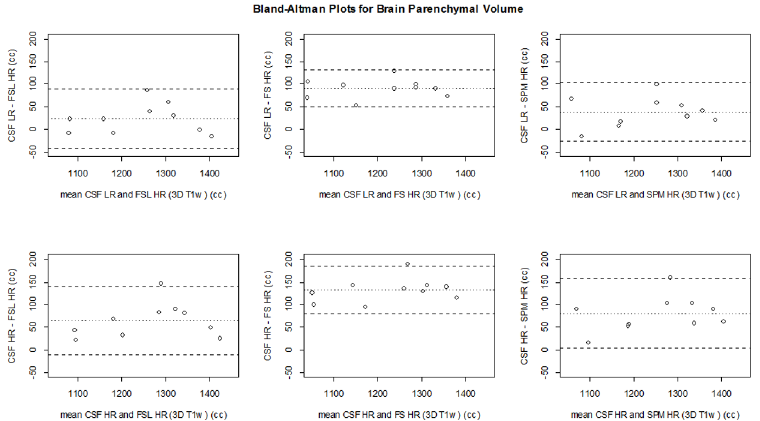
Fig 6. Bland Altman plots for the comparison of BPV between the CSF MRI sequences and the 3D T 1 -based brain segmentation methods. The dashed lines represent the limits of agreement (mean difference ±1.96 (cid:3) SD of the differences). CSF LR = CSF low resolution MRI scan; CSF HR = CSF high resolution MRI scan; FS = FreeSurfer.